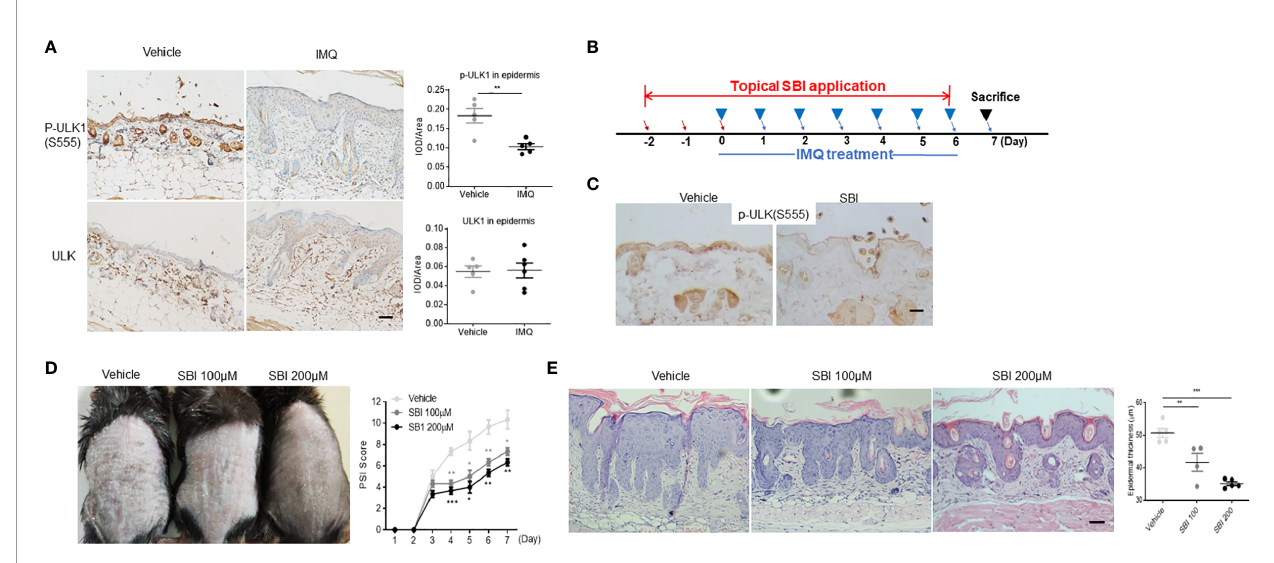
FIGURE 2 | ULK1 inhibitor SBI-0206965 (SBI) ameliorates psoriasiform dermatitis (PsD) induced by imiquimod (IMQ). (A) Representative images and quanti fi cation of immunochemical staining of p-ULK1 (ser555) and ULK1 in dorsal skin from mice treated with topical IMQ or vanicream for 7 days (scale bars, 50 m m). (B) Schematic illustration of experimental protocols. (C) p-ULK1 (ser555) expression in dorsal skin from mice treated with 100 µM SBI as shown in (B) on day 0 (scale bars, 25 m m). (D) Manifestations and the severity of skin in fl ammation measured by PSI score in mice treated as shown in (B) . (E) HE staining and histological analysis of epidermis thickness (scale bars, 50 m m). Data are presented as mean± SEM. *p < 0.05; **p < 0.01; ***p <